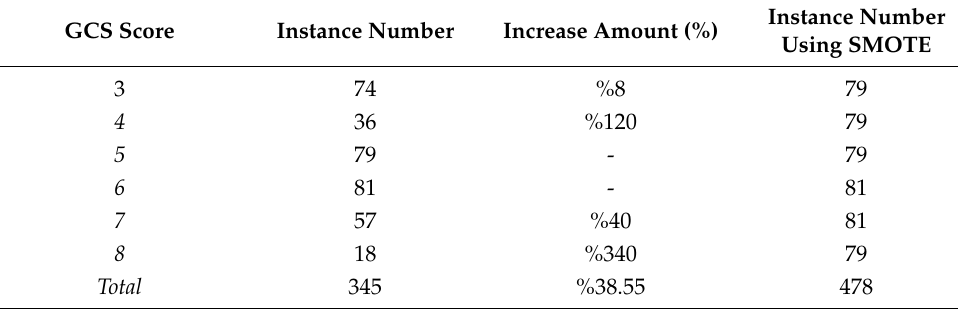
Table 6. Instance number by